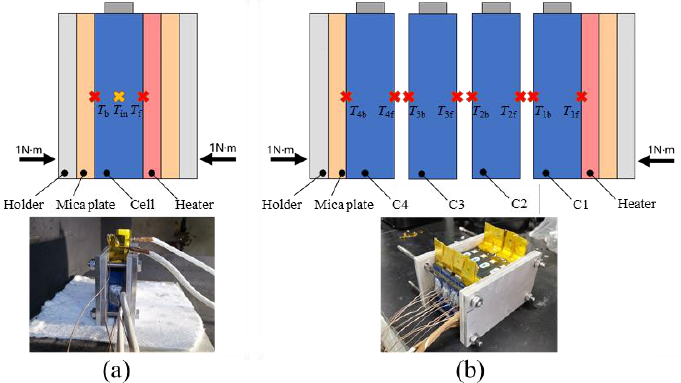
Figure 4. Side-heating abuse test. ( a ) cell test; ( b ) module test.